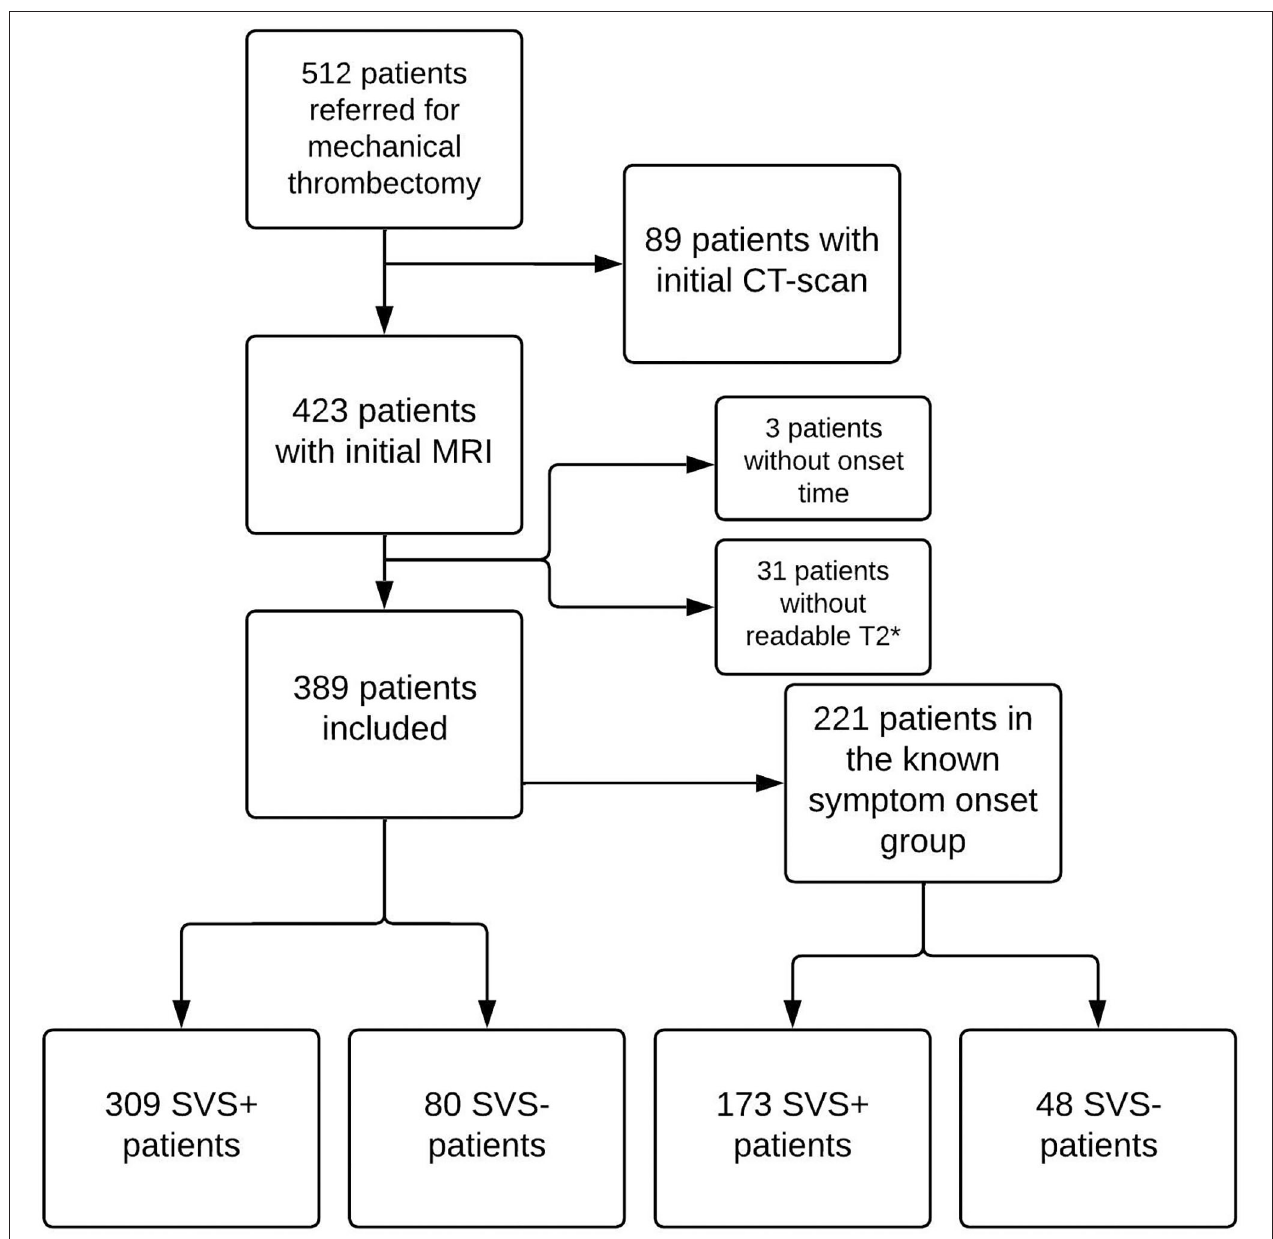
FIGURE 1 | Study flowchart. CT, computed tomography; MRI, Magnetic Resonance Imaging; SVS, susceptibility vessel